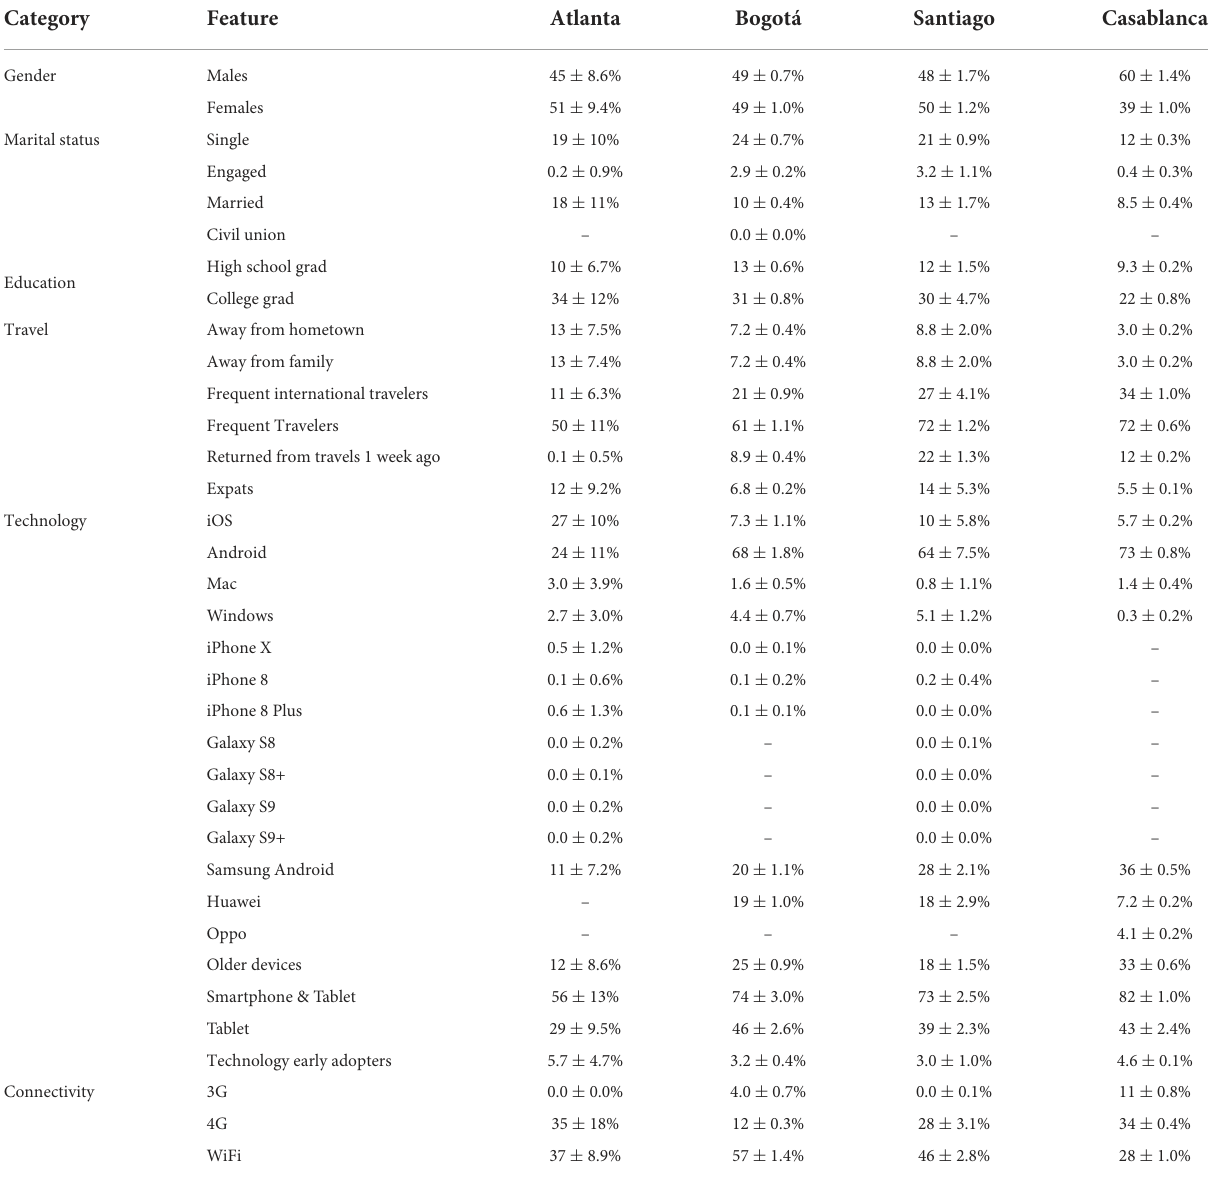
TABLE 2 List of Facebook attributes considered as predictive features of